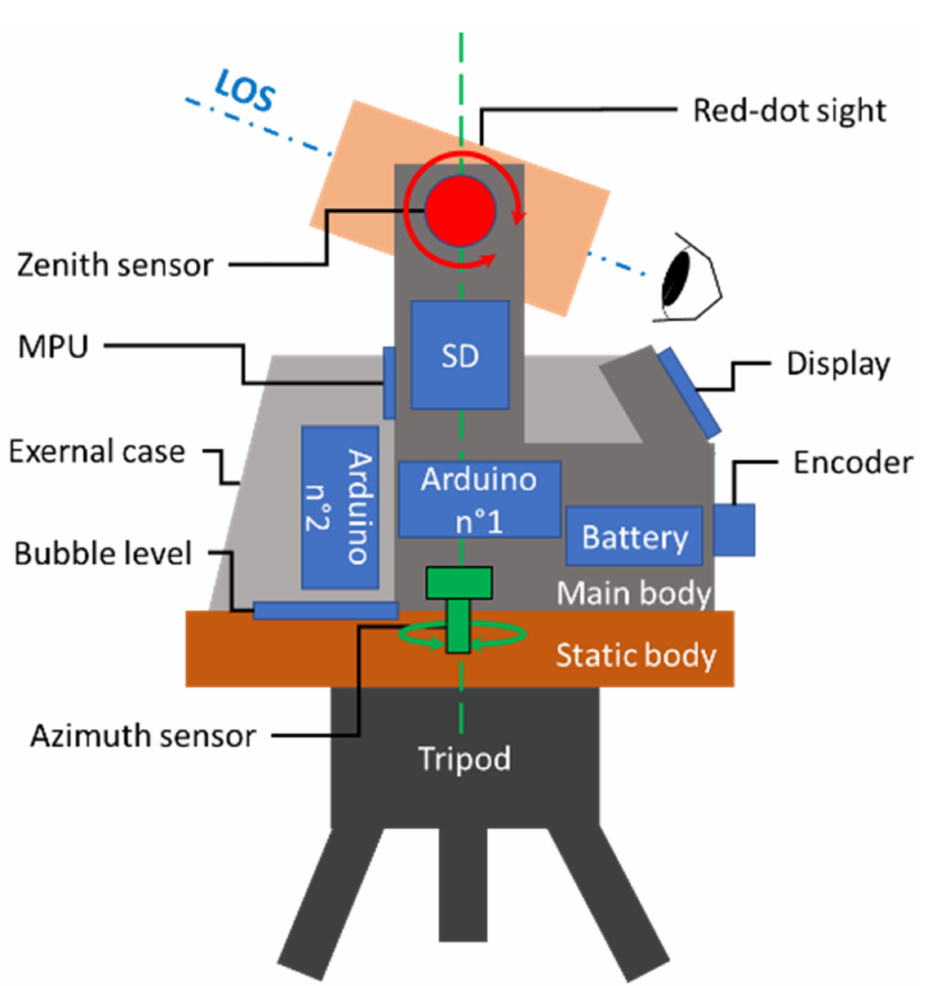
Figure 3. UGO components